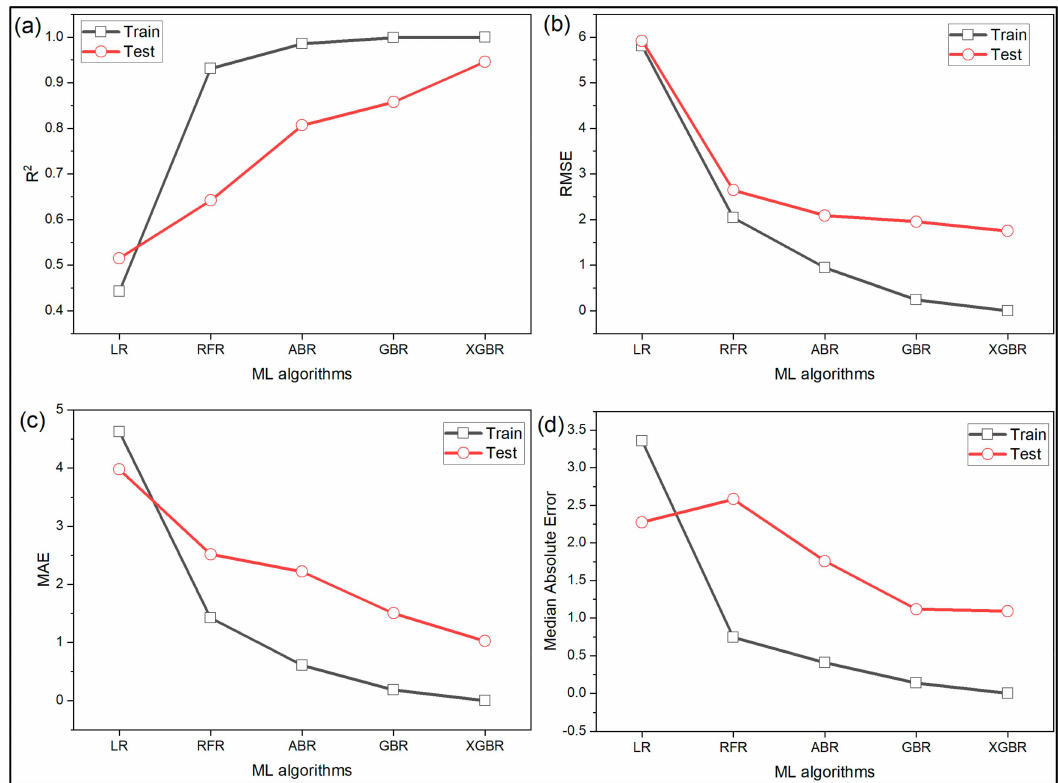
Figure 5. Performance of various ML algorithms measured using ( a ) R 2 ; ( b ) root mean squared error; ( c ) mean absolute error; ( d ) median absolute error for case study